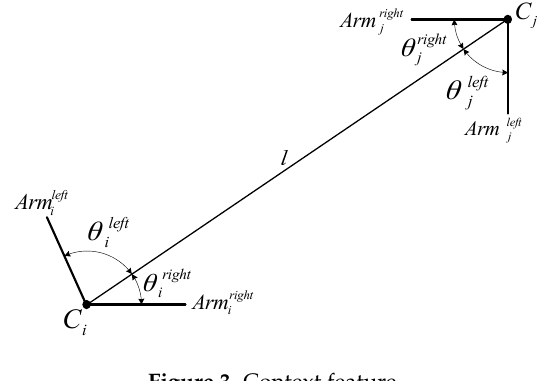
Figure 3. Context feature.